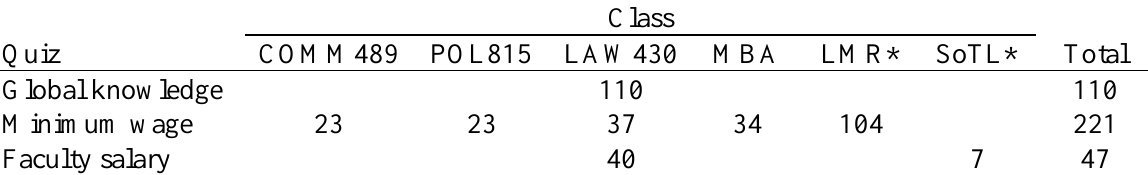
Participants in Anchoring Exercises, University of Saskatchewan,